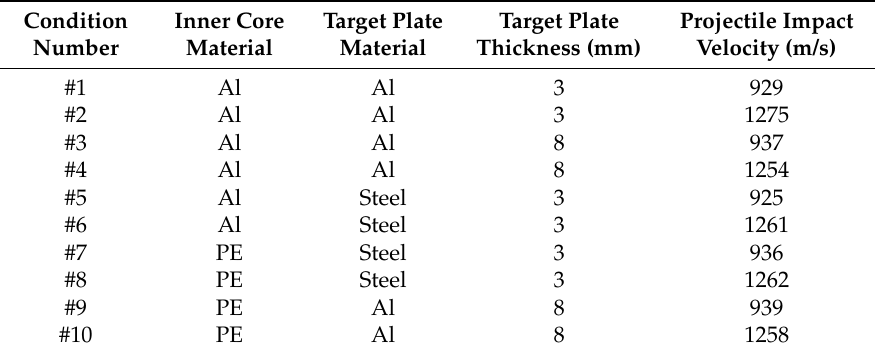
Table 2. Simulation conditions for quantitative analysis.